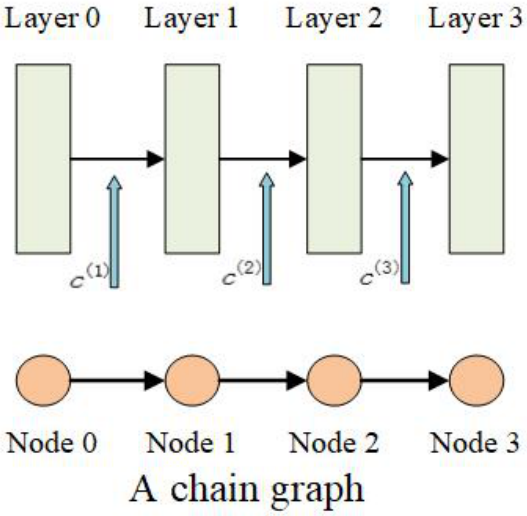
Figure 3. An example of the reject mechanism in a chain